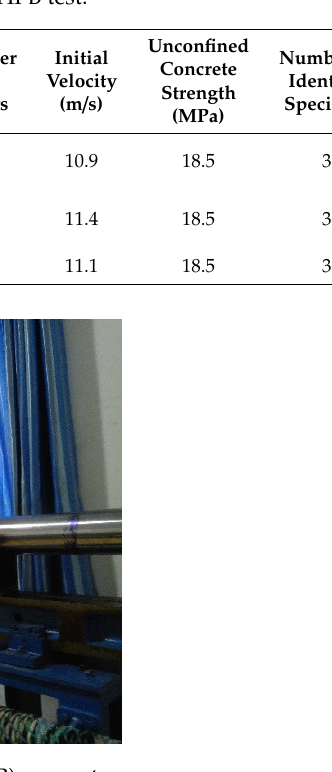
Figure 3. Split Hopkinson pressure bar (SHPB) apparatus. Table 1. Summary of specimens for the SHPB test.